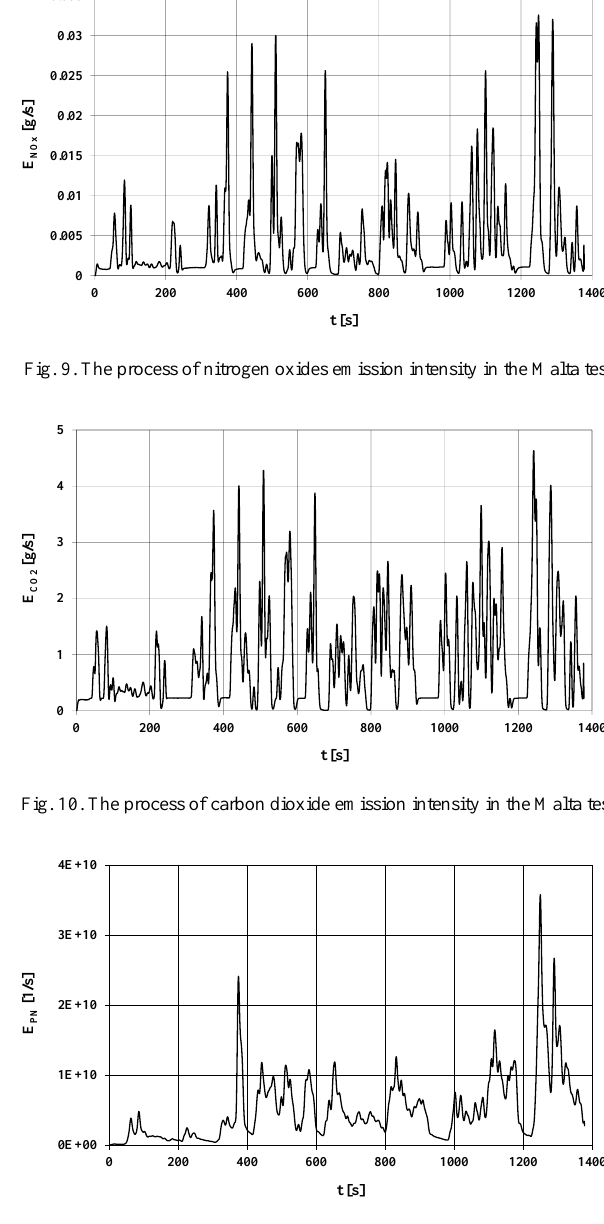
Fig. 11. The process of particle number intensity in the Malta